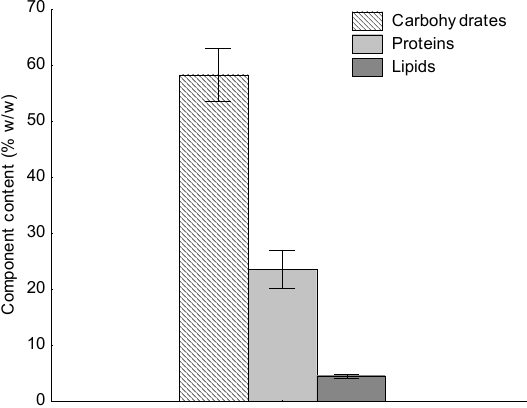
Figure 1. Biomass composition of Arthrospira platensis cultivated under phosphorus limitation in semi-continuous mode. Bars are ±